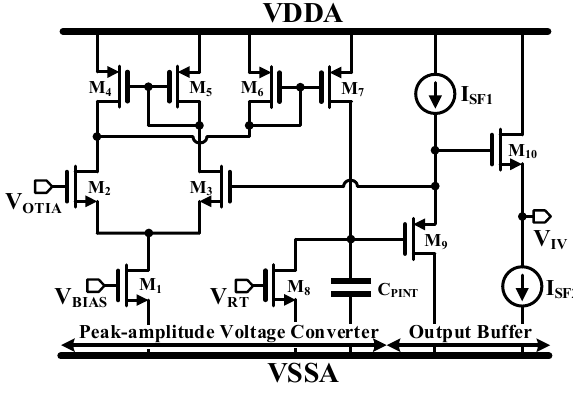
Figure 9. Simplified schematic of a PVC.